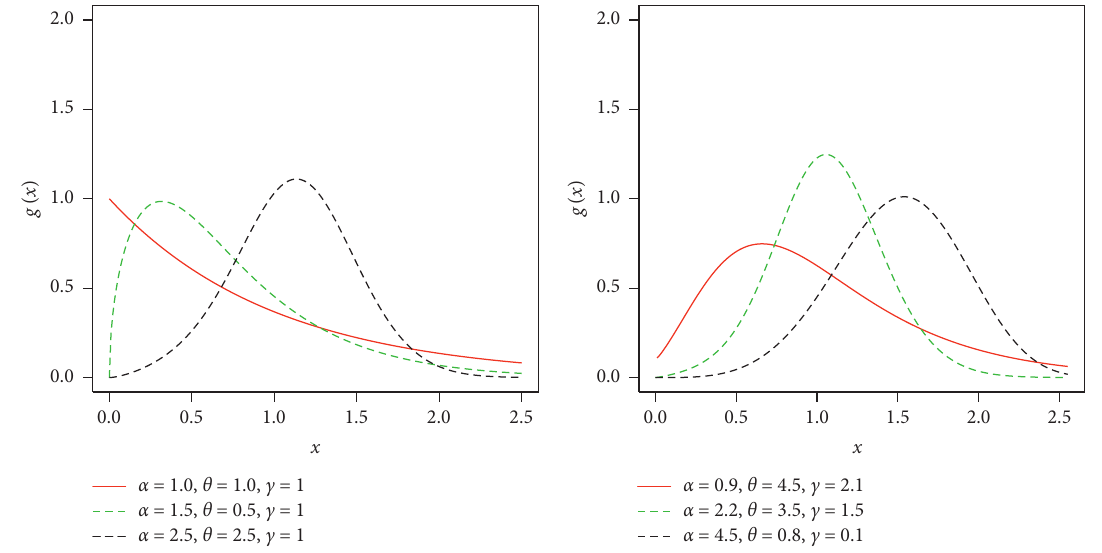
Figure 1: Plots for the density function of the NE-W distribution.